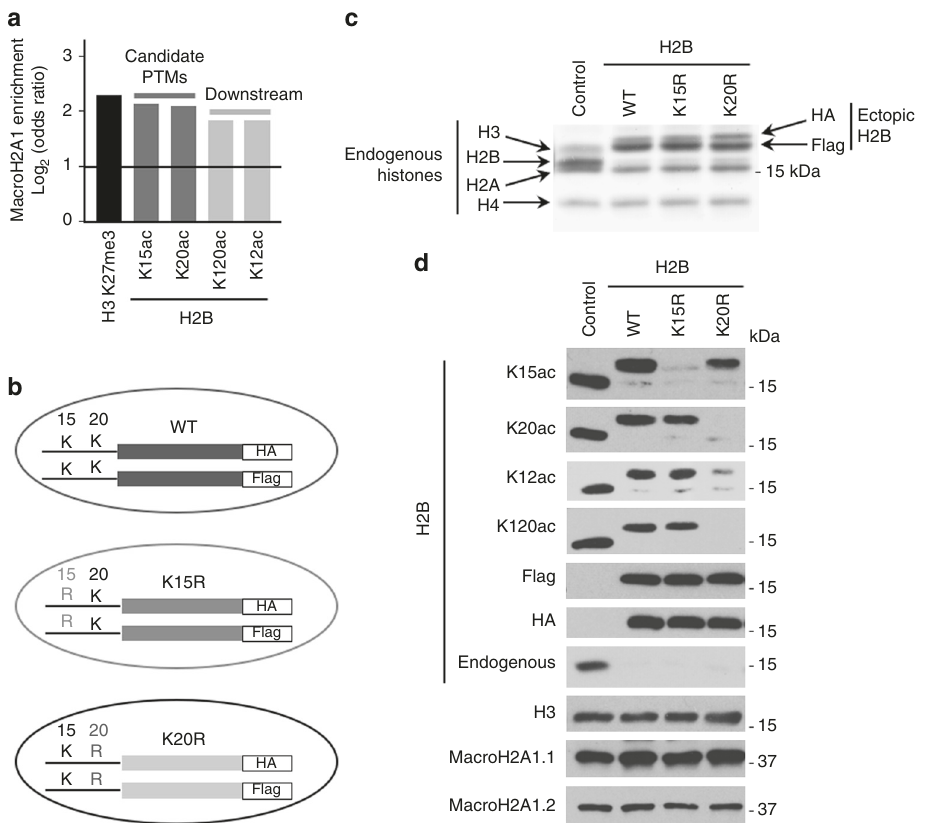
Fig. 3 H2BK20ac is required for acetylation of H2B on K12 and K120. a ChIP-seq data for macroH2A1 and 5 histone PTMs 4 enriched for macroH2A1 in IMR90 cells. b Schematic for co-expression of two ectopic H2B constructs in IMR90-hTERT cells to ablate H2BK15ac and H2BK20ac. (WT, wild-type). c Coomassie-stained gel of acid-extracted histones from cells described in b . Bands corresponding to histones are indicated. d Immunoblots of acid- extracted histones from cell lines described in b for indicated H2B PTMs and H2BK20ac is required for macroH2A1-regulated transcription .